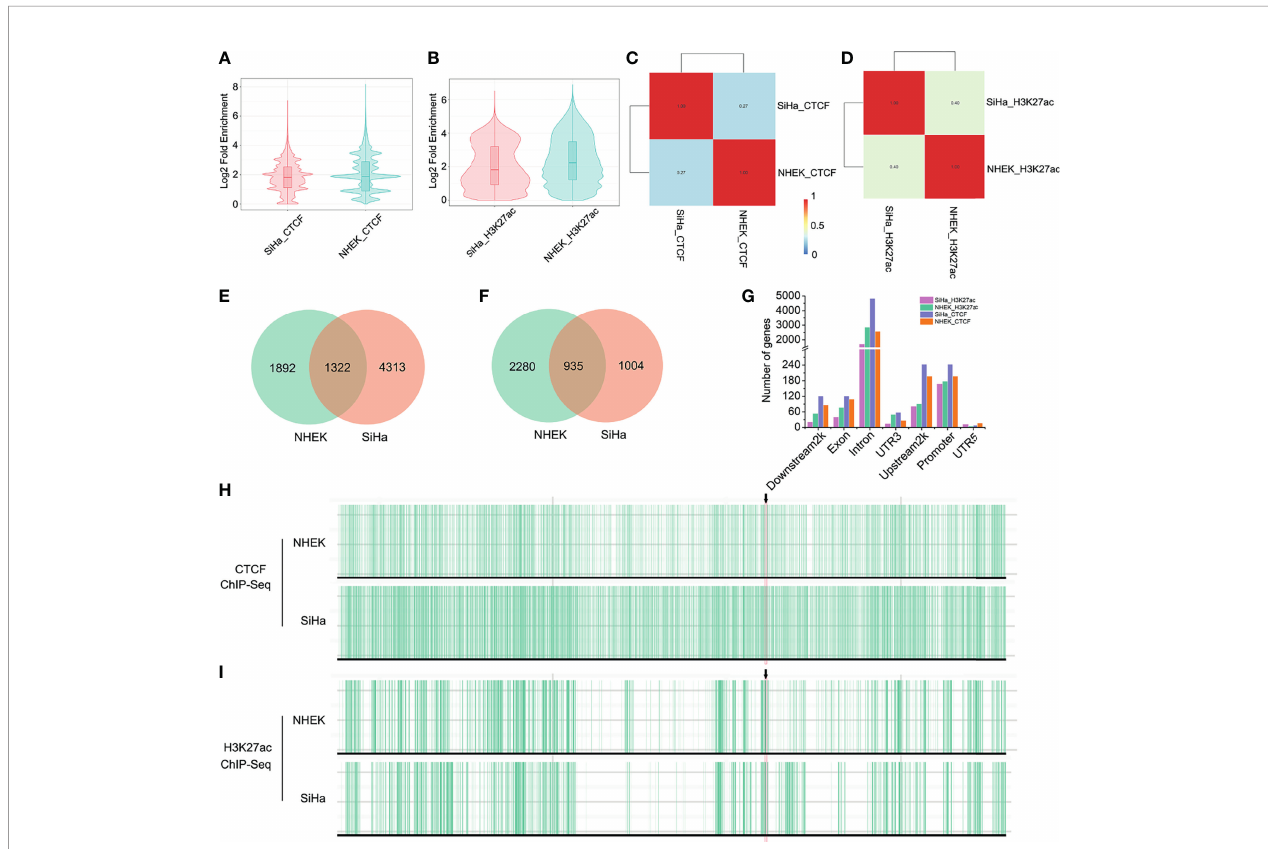
FIGURE 3 | HPV integration altered TAD insulation and enhancer-promoter interaction. (A) Genome-wide distribution of CTCF in SiHa and NHEK. (B) Genome-wide distribution of H3K27ac in SiHa and NHEK. (C) The binding locations of CTCF in SiHa and NHEK. (D) The binding locations of H3K27ac in SiHa and NHEK. (E) The number of unique and shared CTCF between SiHa and NHEK. (F) The number of unique and shared H3K27ac between SiHa and NHEK. (G) The number of CTCF and H3K27ac targeted genes located in different gene regions. (H, I) CTCF and H3K27ac ChIP-seq tracks for the chromosome 13 of SiHa and